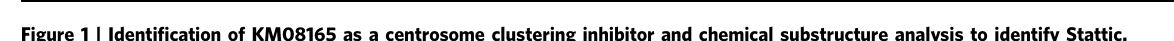
Figure 1 | Identification of KM08165 as a centrosome clustering inhibitor and chemical substructure analysis to identify Stattic. ( a ) Immunofluorescence images of cells treated with KM08165. Mitotic spindle morphology was observed by staining for pericentrin (green), a -tubulin (red) and DNA (Hoechst, blue). Scale bar, 8 m m. ( b ) Quantification of KM08165-dependent inhibition of centrosome clustering in cells derived from